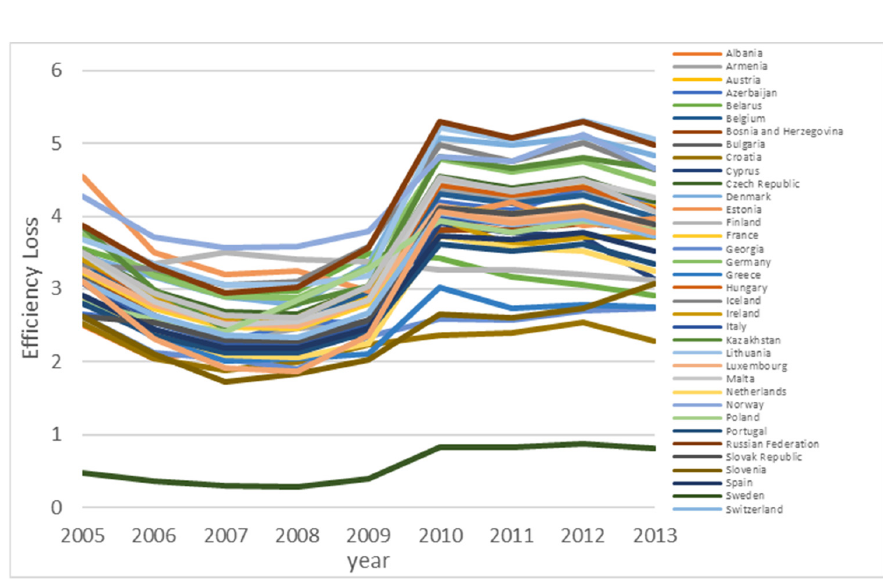
Figure 7. Spatial Spillover for all countries over time.